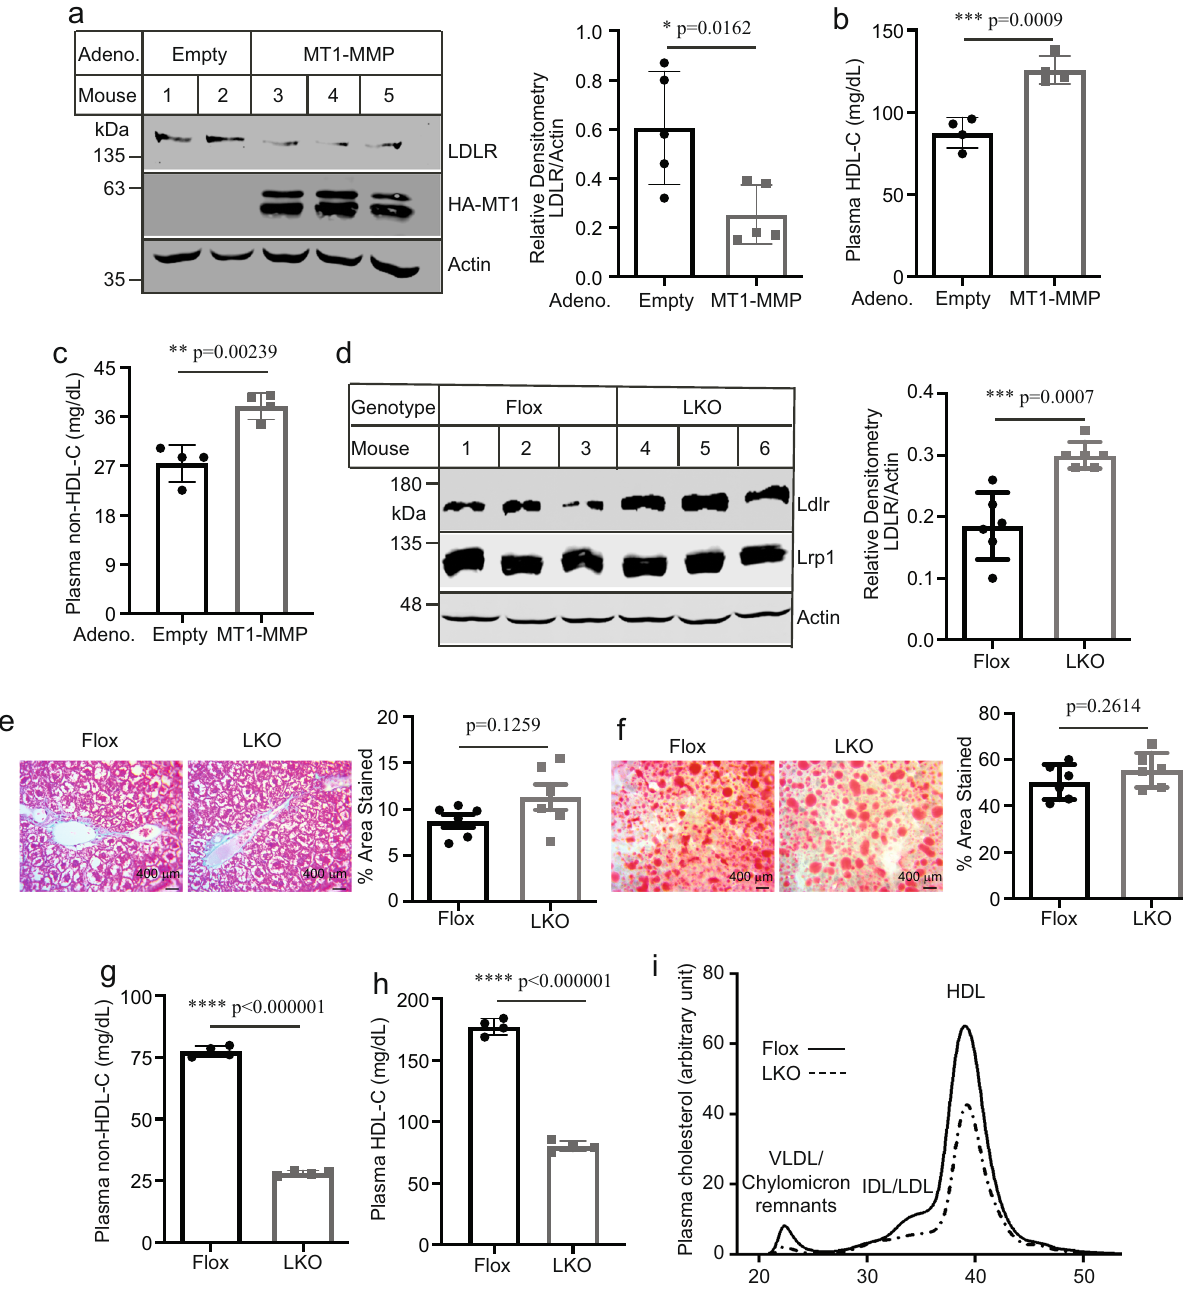
Fig. 5 The impact of MT1-MMP. a Overexpression of human MT1-MMP. Male C57BL/6J mice were injected with empty or the wild-type MT1-MMP adenoviruses (5 mice per group). Liver homogenate was subject to immunoblotting, followed by quanti fi cation of LDLR levels relative to actin in the same mouse. Representative images were shown. Similar results were obtained from other mice. Plasma levels of HDL ( b ) and non-HDL cholesterol ( c ) (4 mice per group). d Effect of the Western-type diet (6 mice per group). Mice were fed the Western-type diet for 8 weeks. Liver homogenate was subjected to immunoblotting. Relative densitometry of LDLR was determined as described. Actin was used as a loading control. Representative images were shown. Similar results were obtained from the other mice. Liver section staining. Representative fi gures and quanti fi cation (ImageJ 1.52S) of Masson ’ s Trichrome ( e ) and oil Red-O staining ( f ) in cross-sections of the liver (6 mice per group). Similar results were obtained from the other mice (magni fi cation: 400×). Plasma levels of cholesterol content in HDL ( g ) and non-HDL ( h ) (4 mice per group). i Lipid pro fi le. Same amount of plasma from each mouse in the same group (2 female and 2 male mice per group) was pooled and applied to FPLC analysis of plasma cholesterol. Student ’ s t test (two-sided) was carried out to determine the signi fi cant differences between groups ( a – h ). The signi fi cance was de fi ned as p < 0.05. Values of all data were mean ± SD. Source data are provided as a Source Data fi